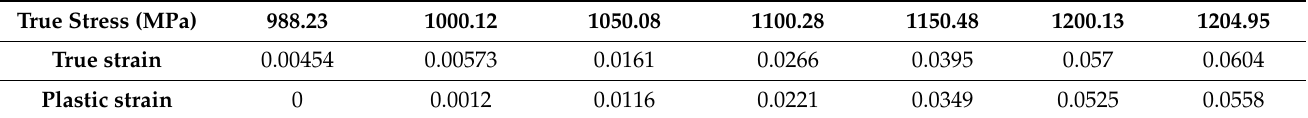
Figure 10. The stress and strain test results of the P125 casing. Table 3. The plastic parameters of P125 casing